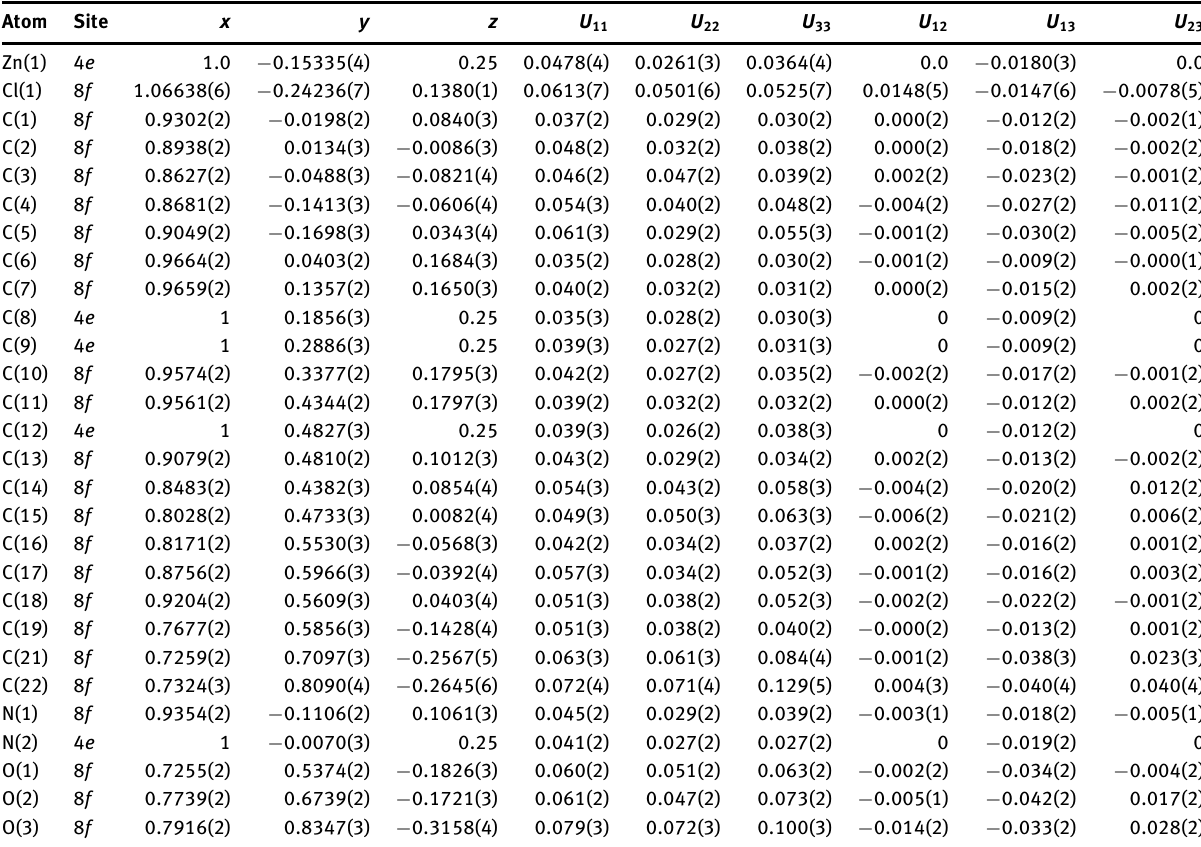
Table 3: Atomic displacement parameters (Å 2 ).